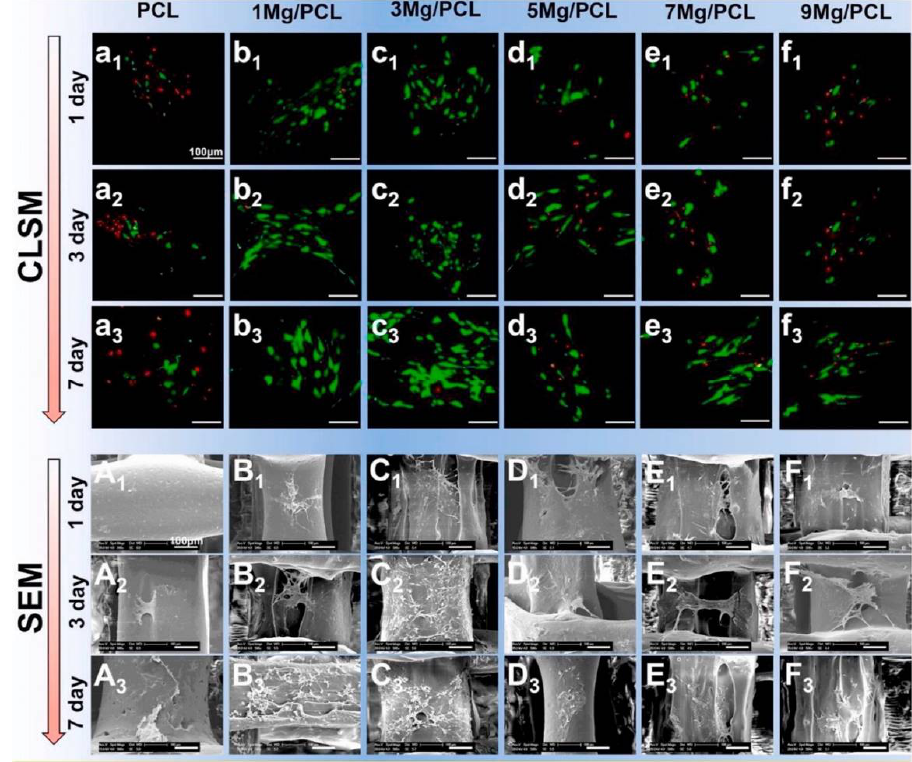
Figure 1. Cell adhesion and proliferation on 3D-printed PCL/Mg composite scaffolds ( a – f ) and SEM images of PLC/MG composite with different amounts of Mg (Mg = 0, 1, 3, 5, 7, and 9 wt %) ( A – F ) [53].